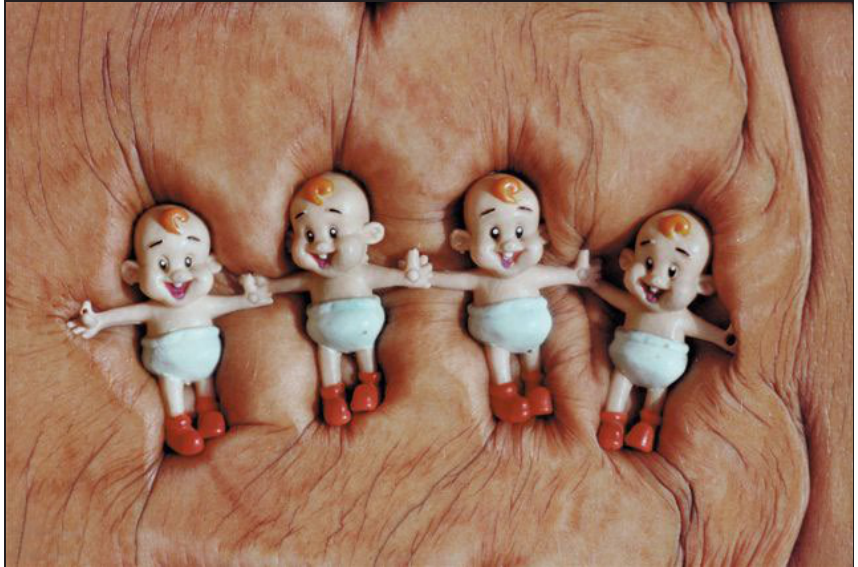
Figure 35: Shira Richter, Waterbed from the Mother, Daughter, and Holy Spirit series , C-prints, 120x180 centimeters,